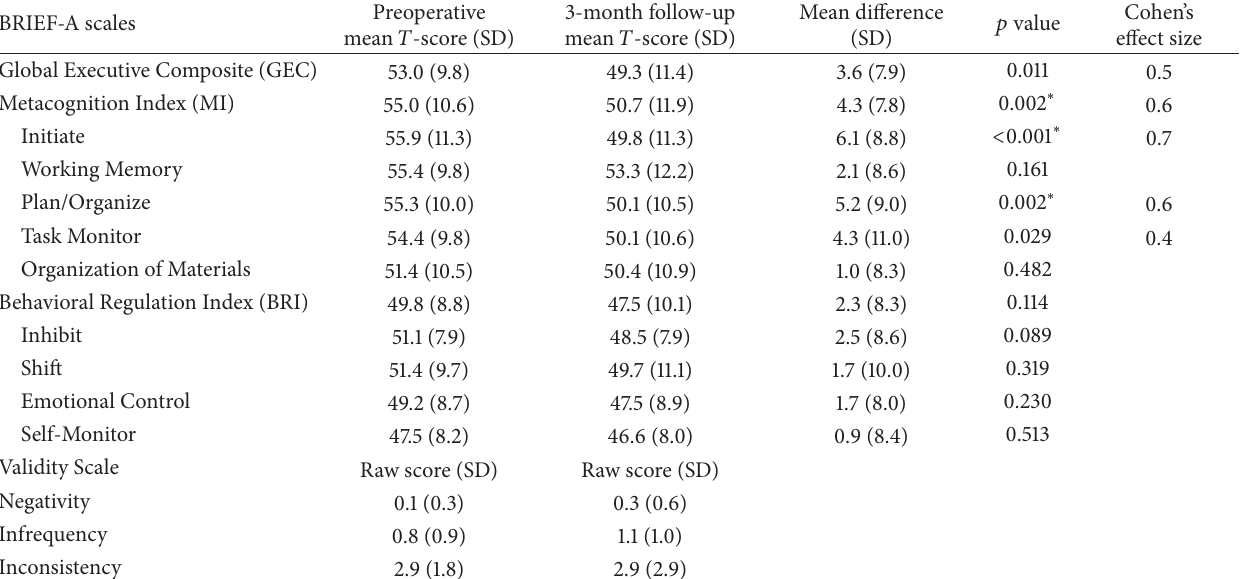
Table 3: Comparison of the BRIEF-A general composite score (GEC), the two index scales (MI and BRI), and the nine clinical subscales (Inhibit, Shift, Emotional Control, Self-Monitor, Initiate, Working Memory, Plan/Organize, Task Monitor, and Organization of Materials), preoperatively and after 3 months of STN-DBS. Group mean 𝑇 -scores and standard deviations (SD) for each scale are reported along with mean differences and 𝑝 values. BRIEF-A validity scales are reported with mean raw scores and standard deviations (SD). ∗ Bonferroni’s adjusted 𝑝